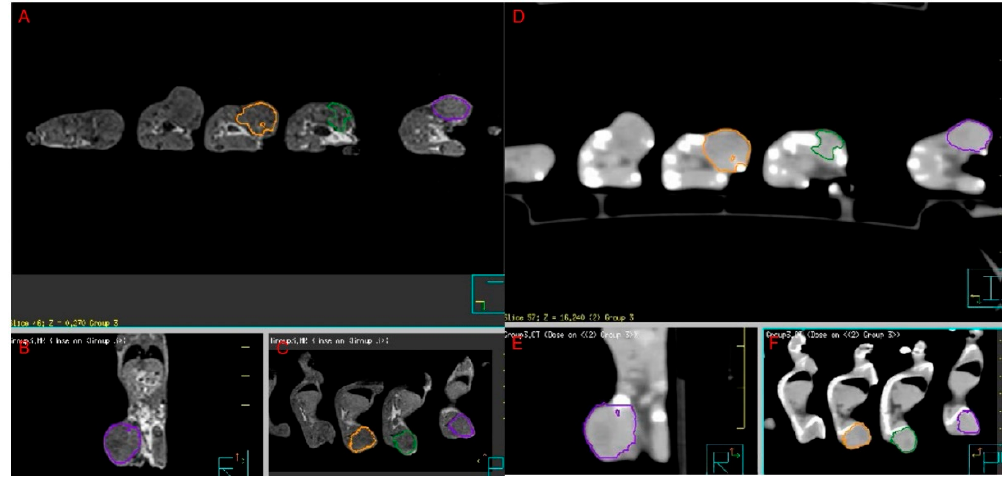
Figure 1. ( A – C ) T1 3T MRI image and ( D – F ) CT image of subcutaneously implanted breast tumors on mice right flanks.